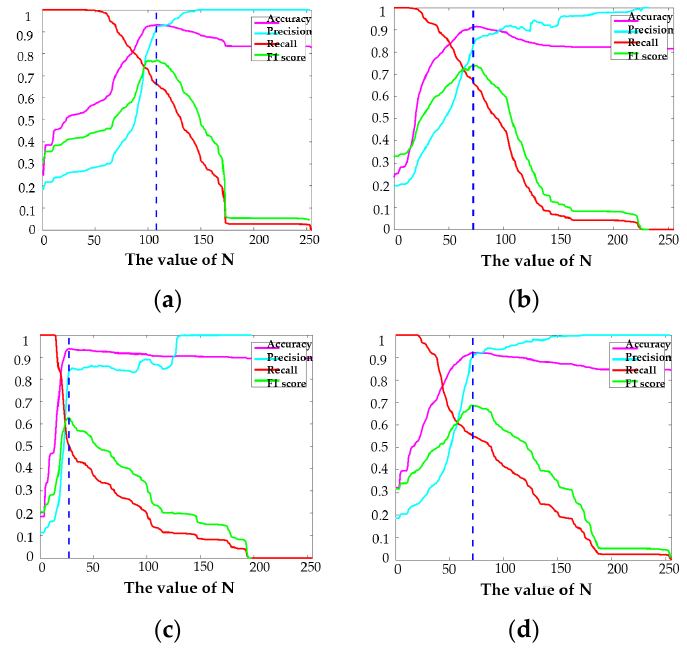
T ∈ . ( a ) Image I, ( b ) Image II, ( c ) Image f